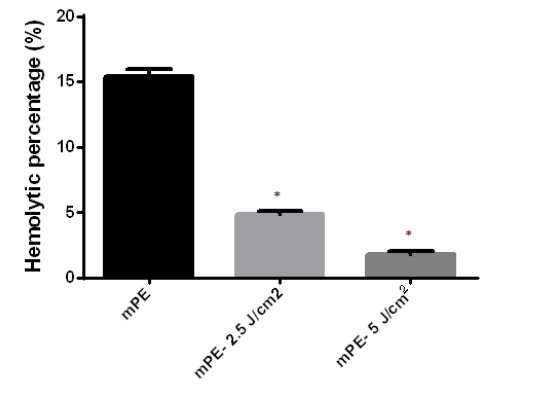
Figure 3 - Hemolysis assay of mPE, mPE-2.5 J/cm 2 and mPE- 5 J/cm 2 treated samples. The mean of the mPE and mPE-2.5 J/ cm 2 and mPE-5 J/cm 2 treated samples along with their standard deviation is indicated from three individual experiments. Further mean differences between the mPE and the mPE-2.5 J/ cm 2 and mPE-5 J/cm 2 treated samples were significant